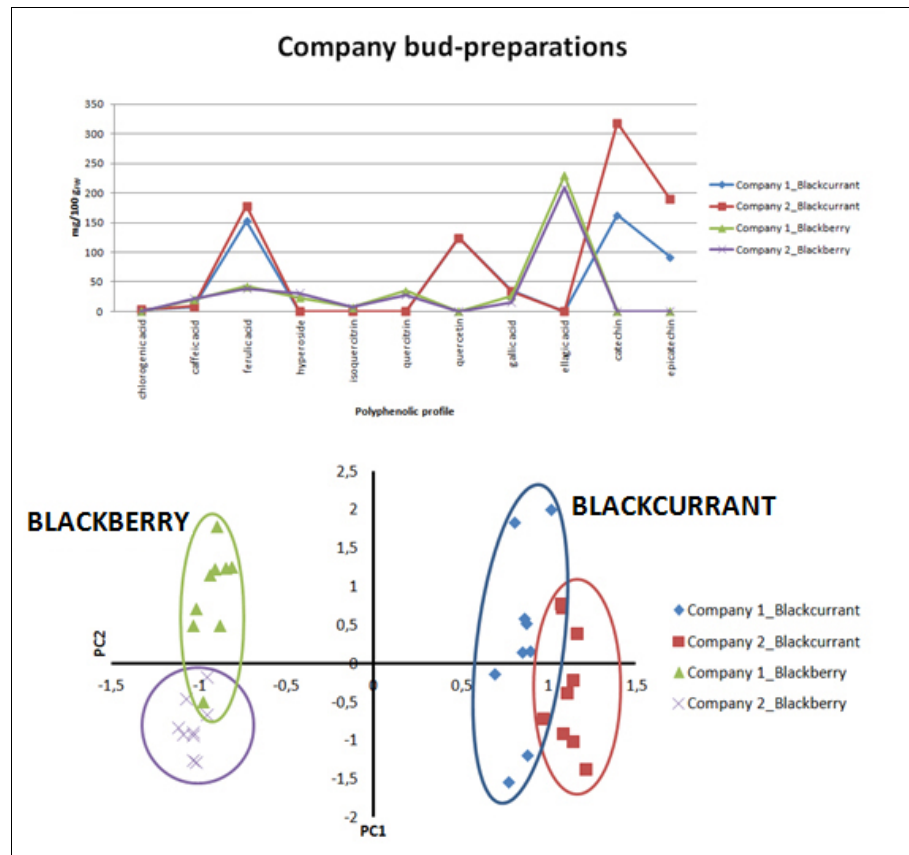
Fig. 8: Company bud- preparations: single polyphenolic profiles and PCA individual